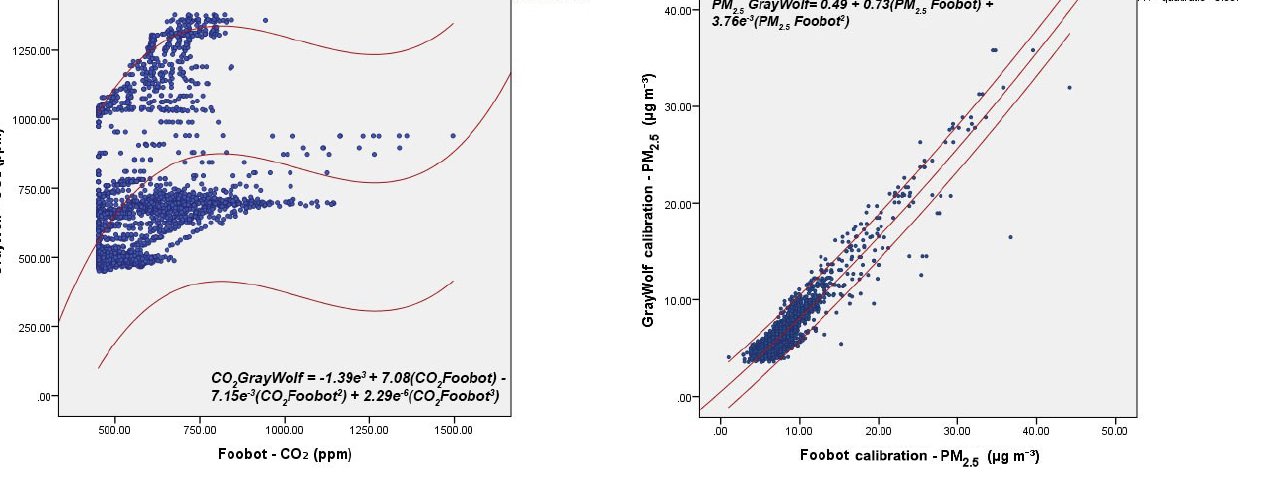
Figure 12. Scatter plot of the 5min PM 2 . 5 concentration measured using the Foobot FBT0002100 and the GrayWolf PC-3016A from the calibration dataset.